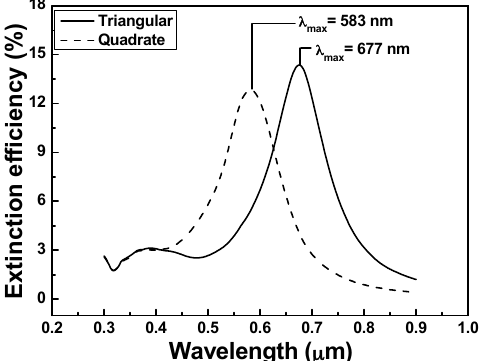
Figure 2. Extinction spectra of the hybrid Au–Ag nanoparticle arrays as a function of monomer shape.